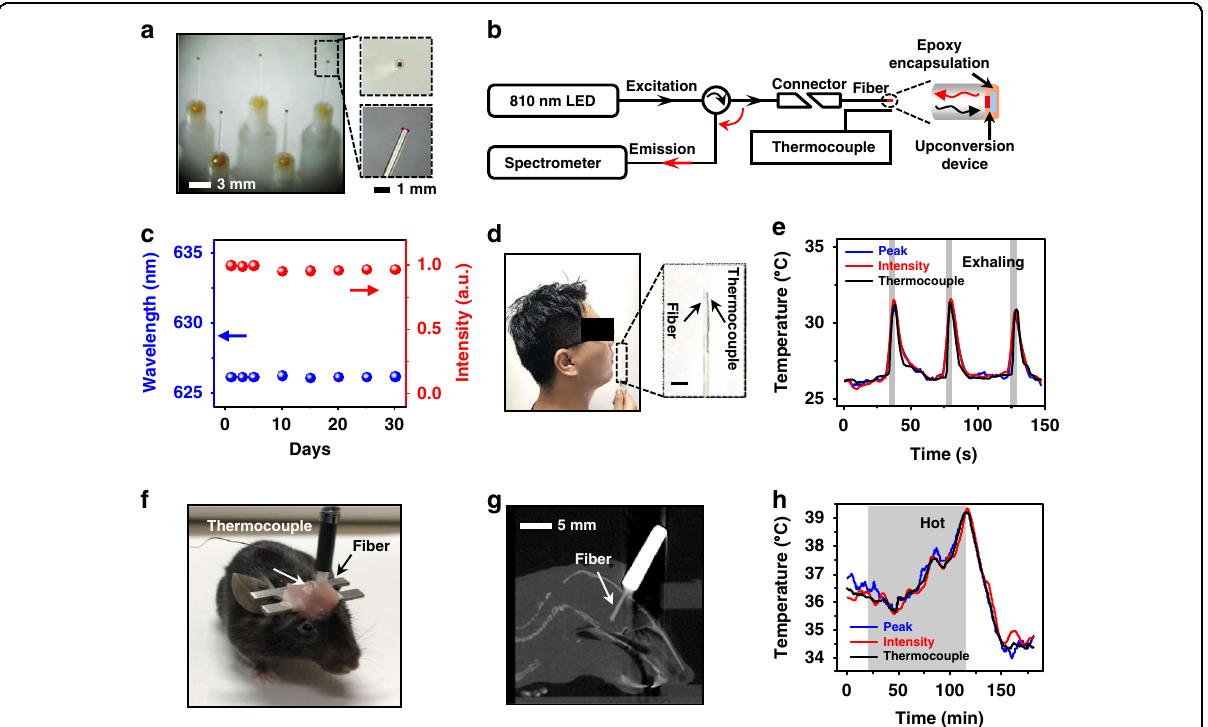
Fig. 4 Optoelectronic upconversion devices integrated with fi ber optics for in vivo temperature sensing. a Photographs of upconversion devices transferred on the tips of silica fi bers (diameter ~600 µm). Enlarged boxes present a zoomed-in view of the fi ber tip with a red-emitting device excited by the coupled near-infrared light. b Schematic illustration of the temperature sensing setup for spectral analysis, mainly including an 810 nm LED source, a spectrometer, and a Y-shaped fi ber, as well as a thermocouple for temperature calibration. c Chronic PL stability of the encapsulated fi ber sensor immersed in PBS for different times at room temperature (~25°C), in which both the peak wavelength and PL intensity are recorded. d Photograph of the exhaling temperature detection with the fi ber sensor. e Dynamic temperature signals during cycled exhaling activities obtained by the fi ber sensor based on the emission peak wavelength shifts and PL intensity changes, compared with results simultaneously recorded by the thermocouple. The gray regions represent actions of exhaling. f Photograph of a behaving mouse with a fi ber sensor and a thermocouple implanted into the brain for temperature sensing. g Sagittal CT reconstruction of a slice, indicating the location of the implanted fi ber. h Dynamic temperature signals obtained in the mouse brain by the fi ber sensor based on the emission peak wavelength shifts and PL intensity changes, compared with results simultaneously recorded by the thermocouple. The shaded gray region represents the time period when the mouse is placed in a hot environment at around 40